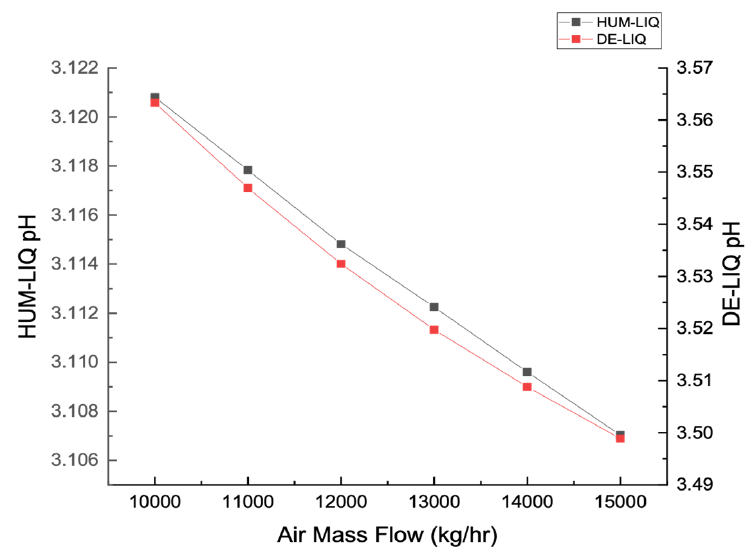
Figure 6. HUM-LIQ pH and DE-LIQ pH as a function of feed air mass flow.